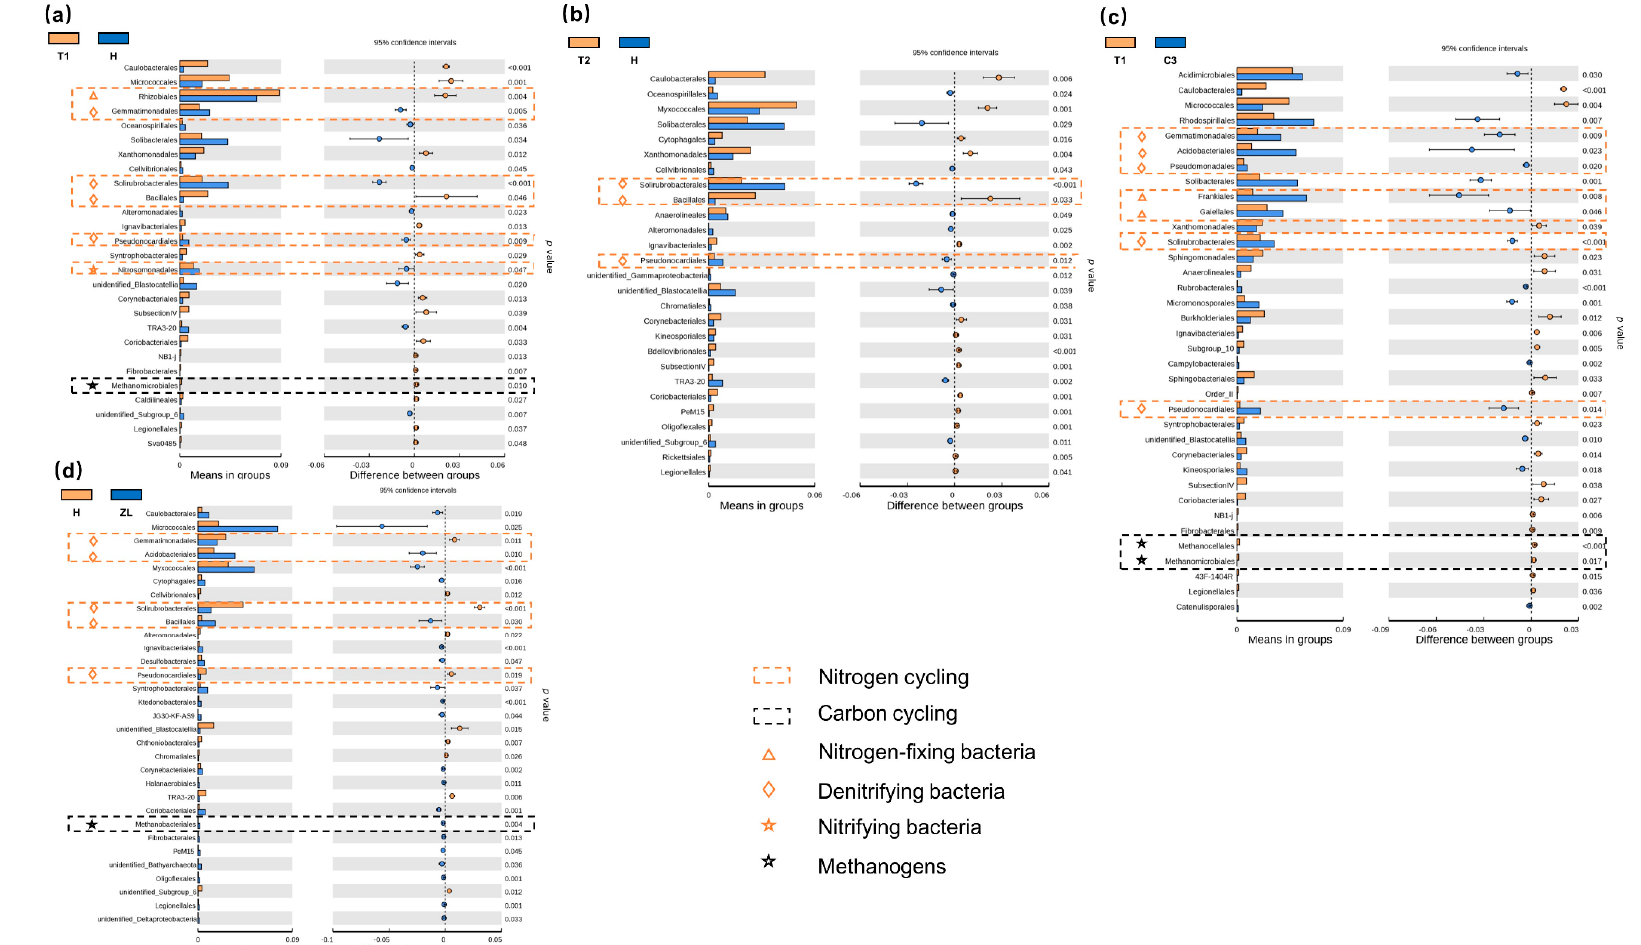
Figure 4. A comparison of the relative abundance of two soil bacterial groups between the natural and degraded Carex wetlands at the level of bacterial orders. ( a ) comparison between T1 and H sites; ( b ) comparison between T2 and H sites; ( c ) comparison between T1 and C3 sites; ( d ) comparison between H and ZL sites. The significance of differences between two groups was determined using the t -test with 95% confidence intervals. The orange and black dashed boxes represent typical bacteria involved in nitrogen and carbon cycling, respectively. Nitrogen-fixing, denitrifying, and nitrifying bacteria are marked by orange triangles, diamonds, and pentacles, respectively. Methanogens are marked by black